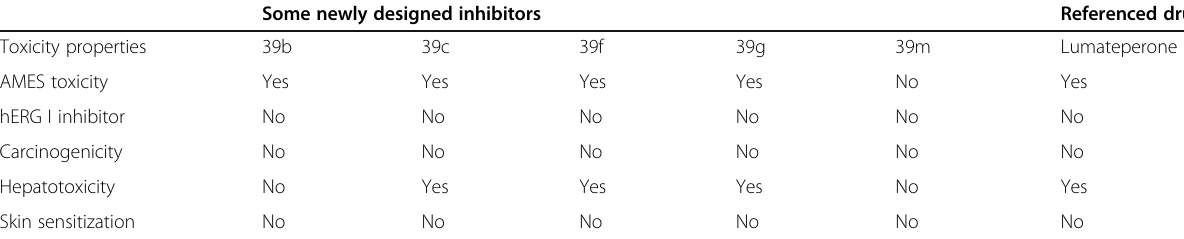
Table 5 In silico toxicity profiles of some designed inhibitors Some newly designed